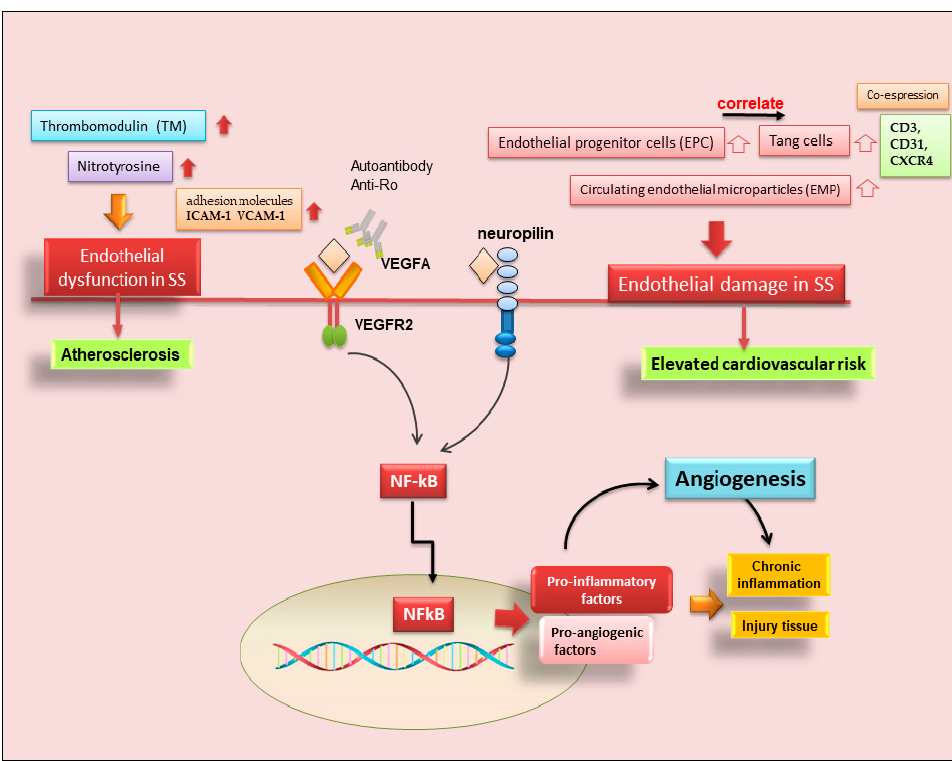
Figure 3. Role of angiogenesis in SS and SS-related diseases. Cluster of differentiation 3 (CD3); cluster of differentiation 31 (CD31); chemokine receptor type 4 (CXCR4); intercellular adhesion molecule 1 (ICAM-1); nuclear factor kappa B (NF-kB); vascular cell adhesion molecule 1 (VCAM-1); vascular endothelial growth factor A (VEGFA); vascular endothelial growth factor receptor 2